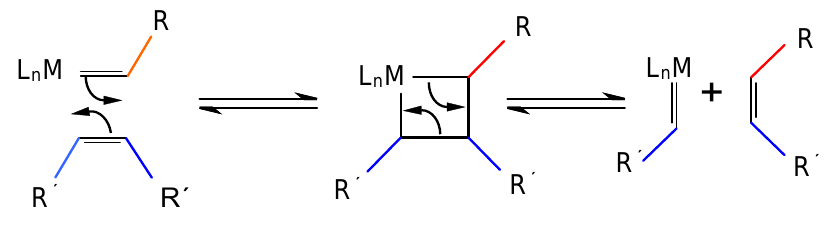
Figure 1. Typical Schrock carbenes.